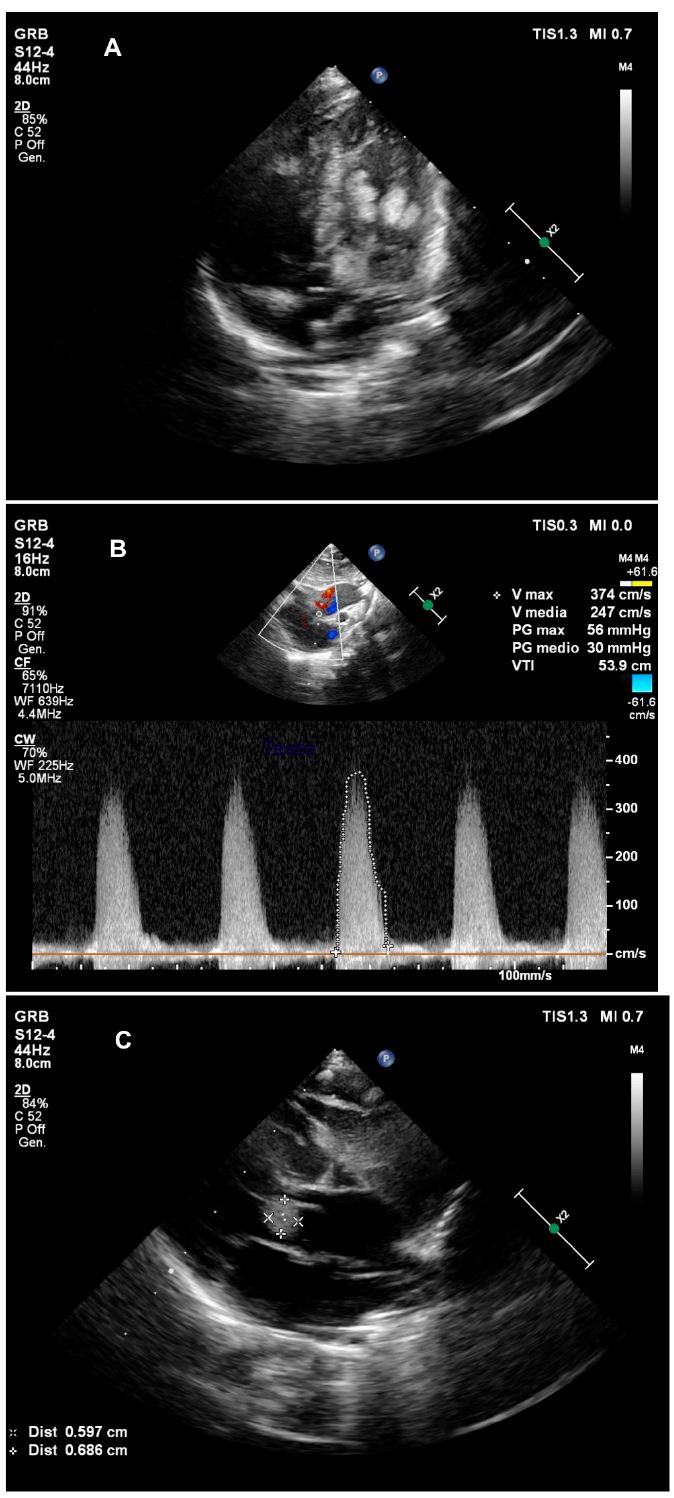
Figure 1. Echocardiogram on the first day of life. Panel ( A ): Left ventricle rhabdomyomas; Panel ( B ): Elevated transaortic gradient; Panel ( C ): Subaortic mass. After 6 months of therapy, an echocardiogram revealed that the mass in the inter- ventricular septum and the masses attached to the mitral chordae were not visible, the subaortic mass was 5 × 2 mm, blood passage was normal, as were the transaortic gradi-